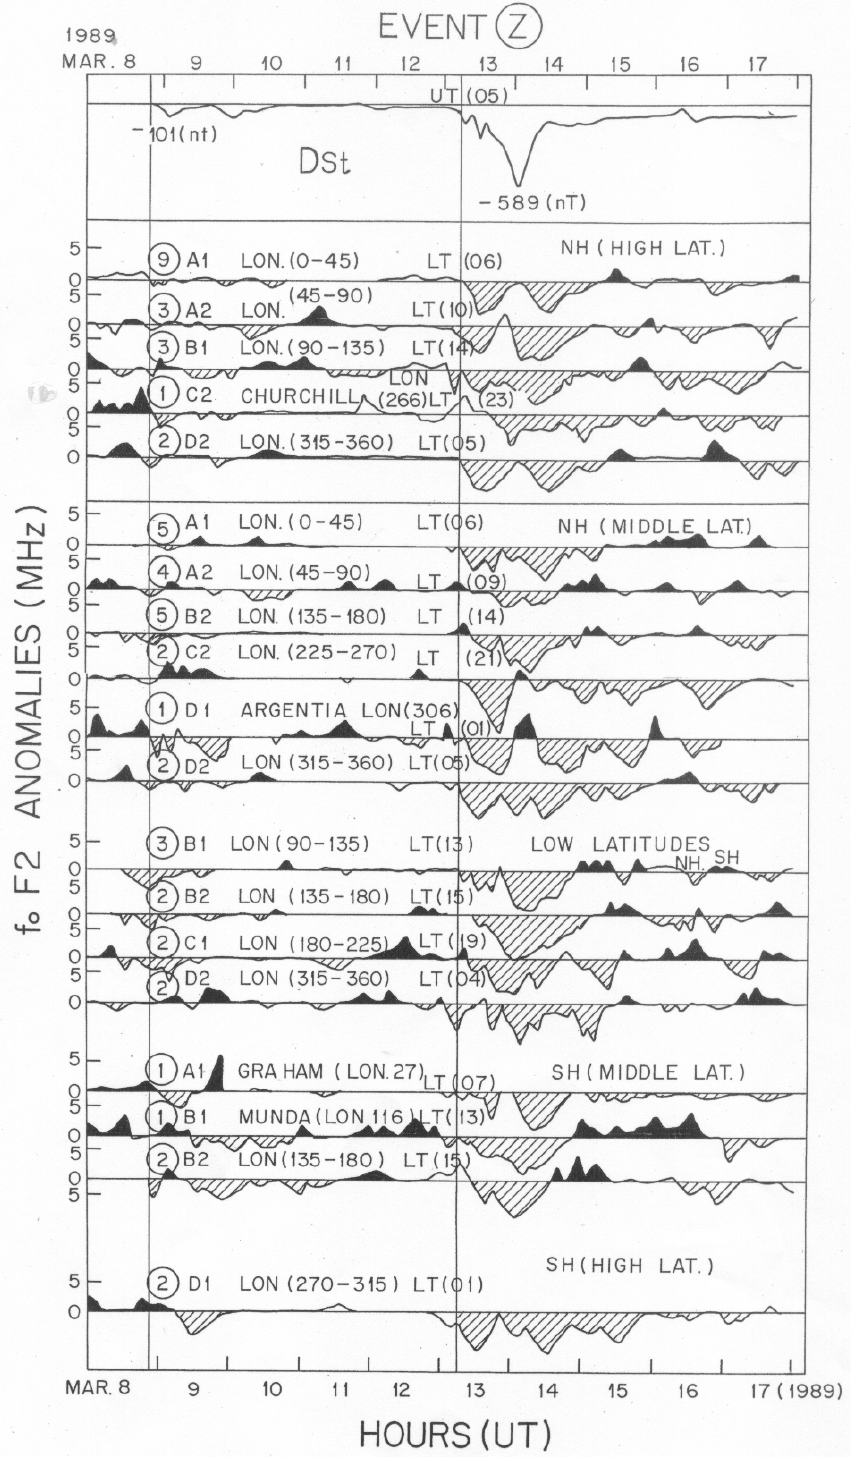
Fig. 6. Plots for the interval 8–17 March, 1989, containing the giant Event Z (13–14 March 1989) for D st (top plot) and the f o F2 anomalies (MHz), for averages of stations in different latitudes: NH high latitudes ( > 50 ◦ N), NH middle latitudes (30 ◦ N–50 ◦ N), low latitudes (30 ◦ N– 30 ◦ S), SH middle latitudes (30 ◦ S–50 ◦ S) and SH high latitudes ( > 50 ◦ S), for longitude ranges: A1 and A2, 0 ◦ –45 ◦ E, 45 ◦ E–90 ◦ E; B1 and B2, 90 ◦ E–135 ◦ E, 135 ◦ E–180 ◦ E; C1 and C2, 180 ◦ E–225 ◦ E, 225 ◦ E–270 ◦ E; D1 and D2, 270 ◦ E–315 ◦ E, 315 ◦ E–360 ◦ E. Numbers in circles indicate the number of stations involved in averaging. Vertical lines mark the storm commencements, for the minor storm of 8 March and the major storm of 13 March. Positive deviations are painted black, negative deviations are shown as